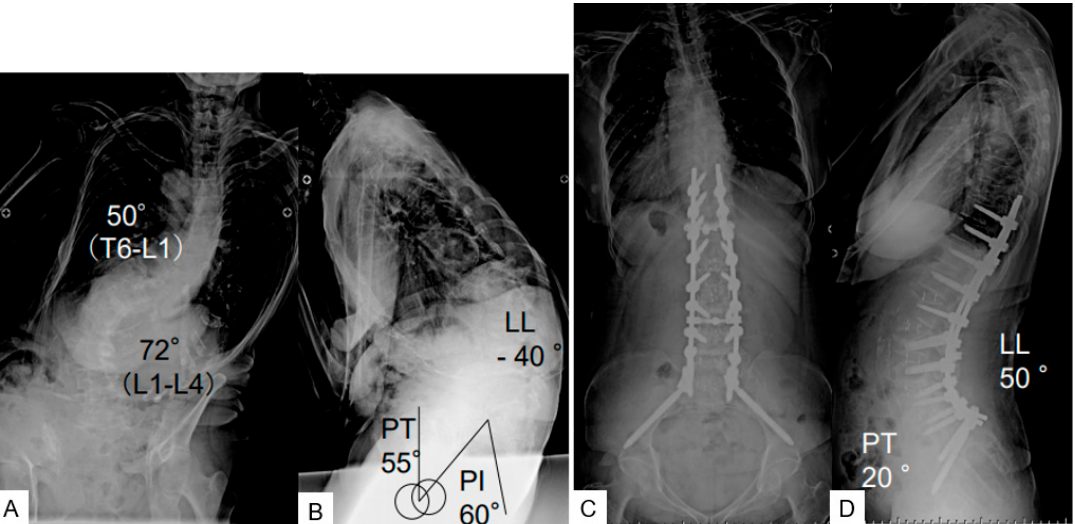
Figure 1. A 79 female, adult spinal deformity, ( A ): preoperative posteroanterior radiogram, ( B ): preoperative lateral radiogram, PI 60 ° , PT 55 ° , LL − 44 ° , SVA 150 mm, PI-LL 100 ° , ( C ): postoperative posteroanterior radiogram, PI 60 ° , PT 20 ° , LL 50 ° , SVA − 15 mm, PI-LL 10 ° , ( D ): postoperative lateral radiogram.